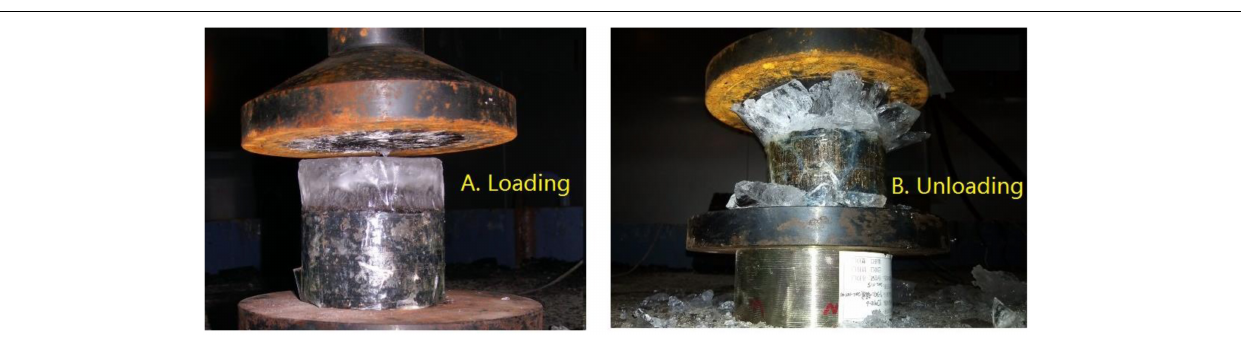
FIGURE 5 | (A) Test picture under loading conditions. (B) Test picture under unloading